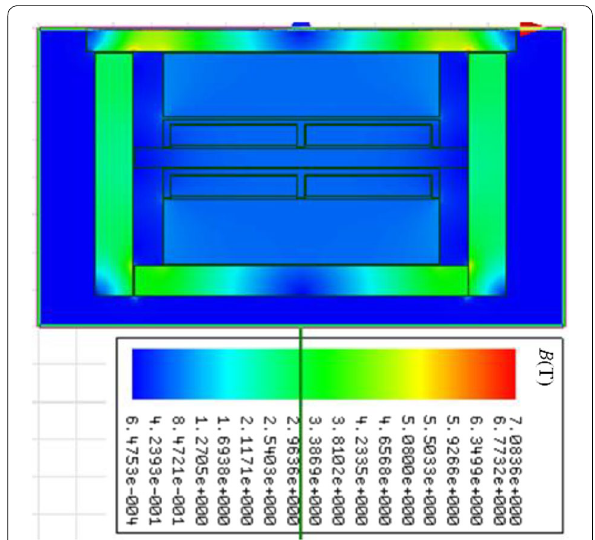
Figure 5 Magnetic field intensity with the same magnetization direction